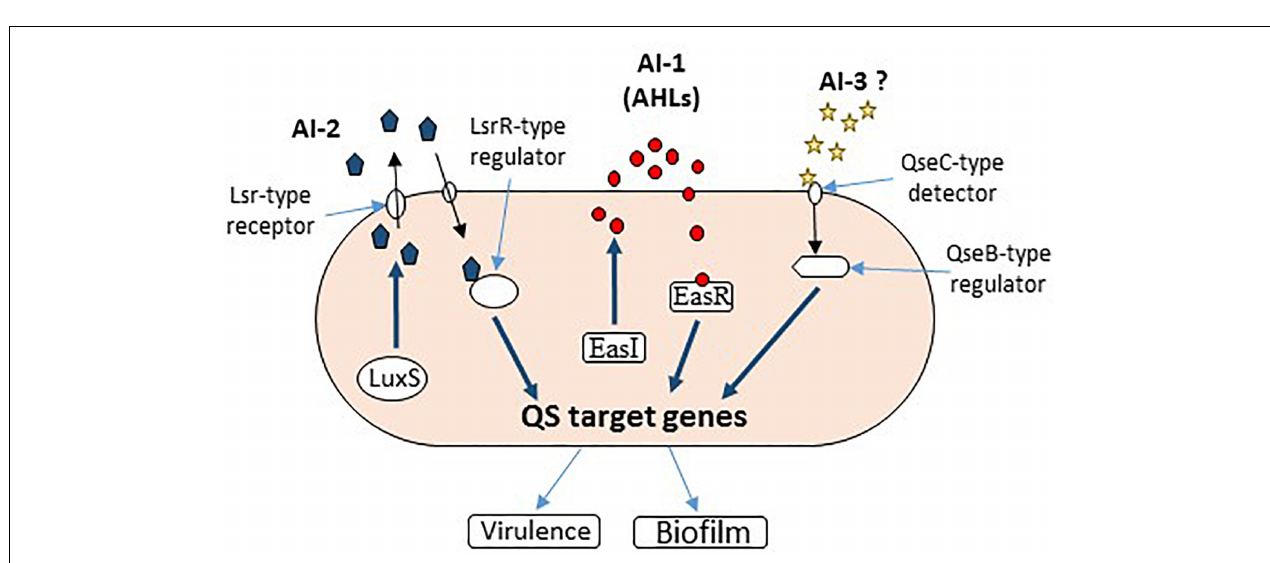
FIGURE 2 | AI-2 dependent QS signaling in Klebsiella sp. SAM, S -adenosyl methionine; DPD, 4,5-dihydroxy-2,3-pentanedione.